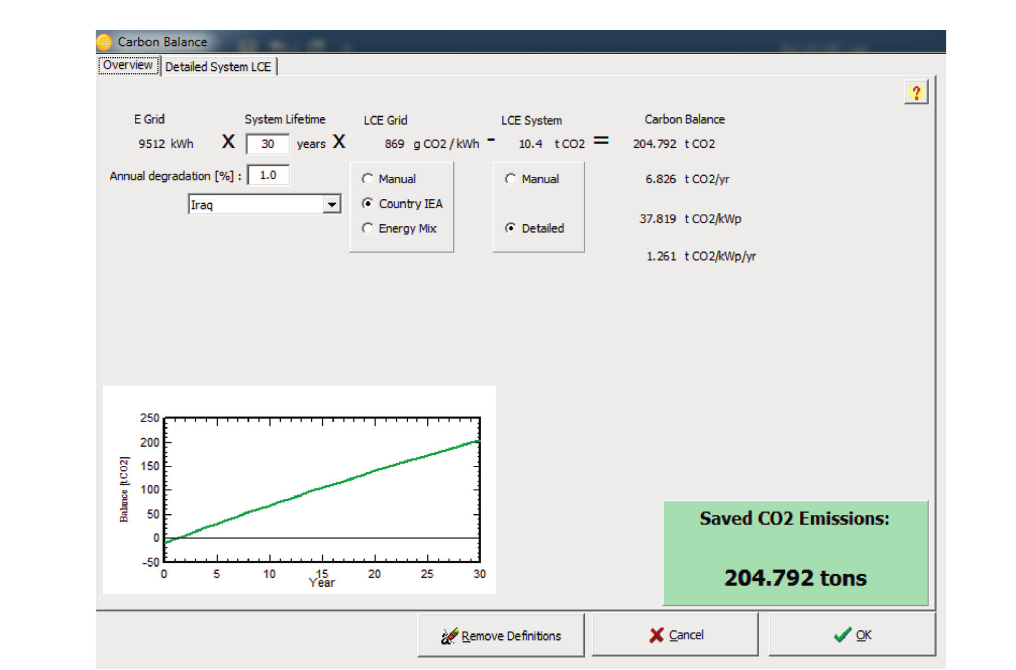
Figure 9: The proposed system of saving